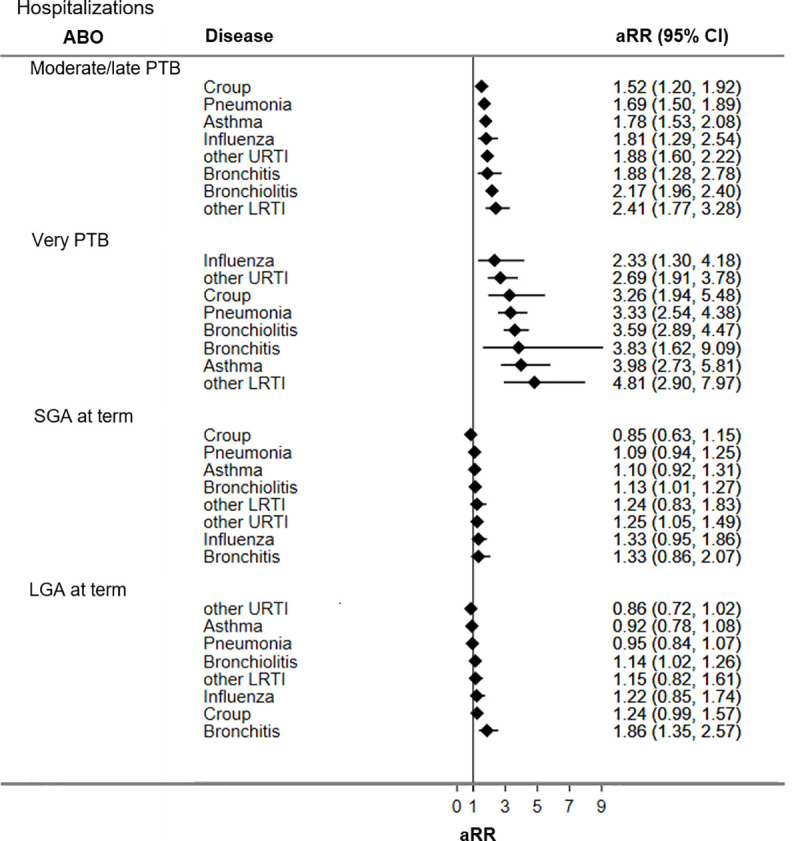
Adjusted rate ratios of respiratory ED visits for adverse birth groups.CI = confidence interval; LGA = large for gestational age; LRTI = lower respiratory tract infections; URTI = upper respiratory tract infections; PTB = preterm birth; SGA = small for gestational age. Reference group = appropriate-for-gestational age infants born at term; aRR = rate ratio adjusted for sex, bronchopulmonary dysplasia, Apgar 5, score, use of significant resuscitative measures, material and social deprivation.